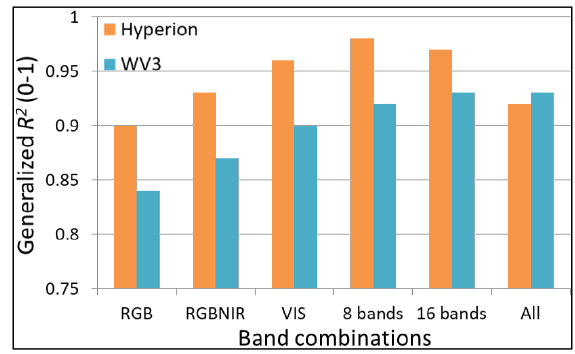
Figure 5. Hyperion and WorldView-3 comparison of the classification performances using one-layered artificial neural networks for the 10 classes investigated